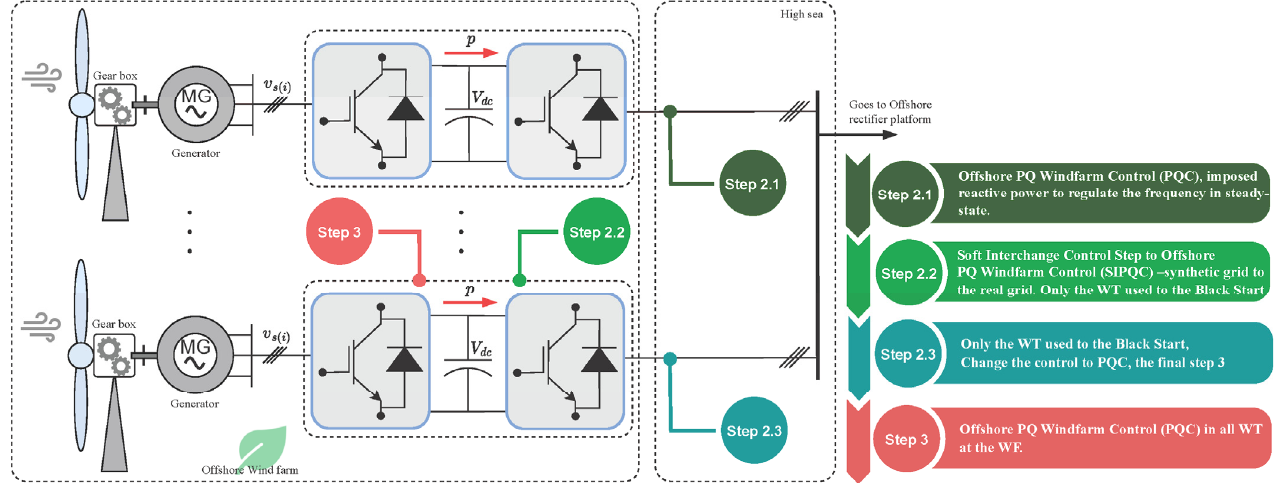
Figure 4. Control flow diagram to pass the WT from black start to PQC control, remaining in the steady state.